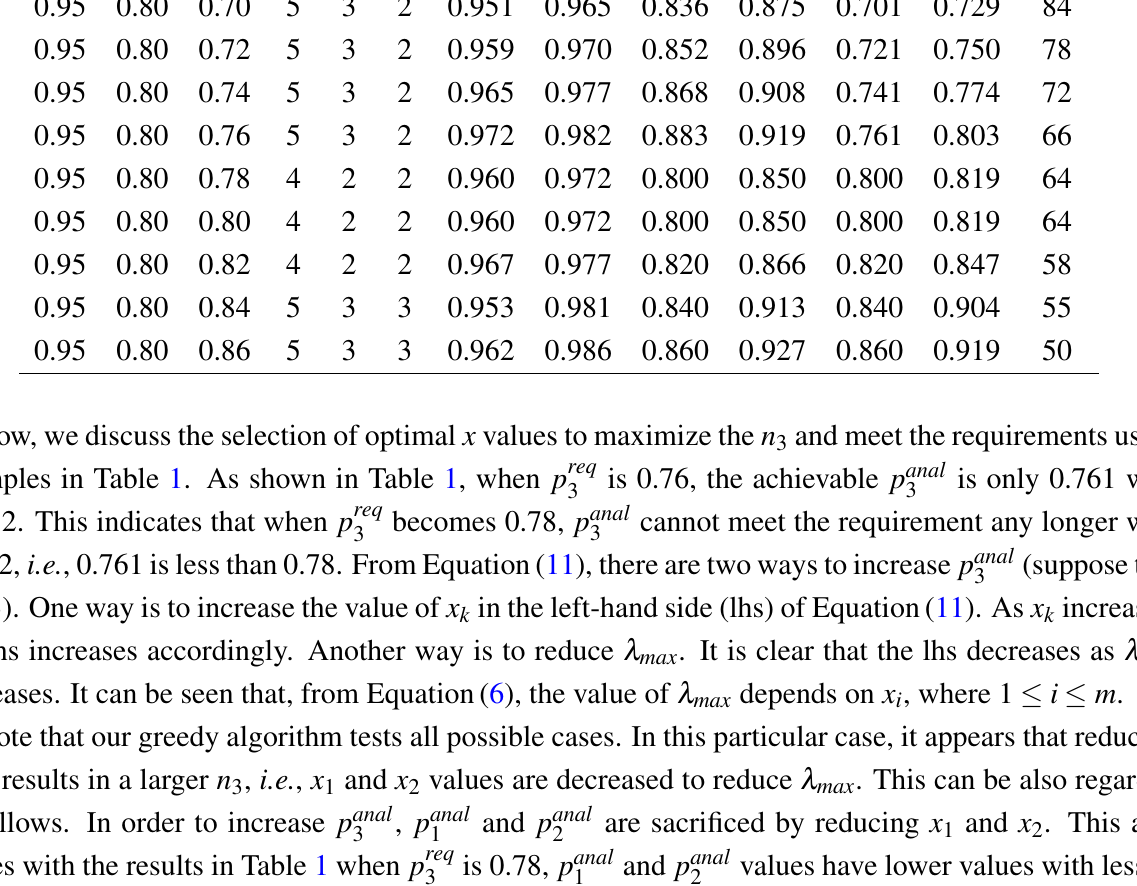
Table 1. The effects of the packet delivery ratio (PDR) requirement for class Q achieved from the greedy algorithm and the maximum number of nodes in class Q